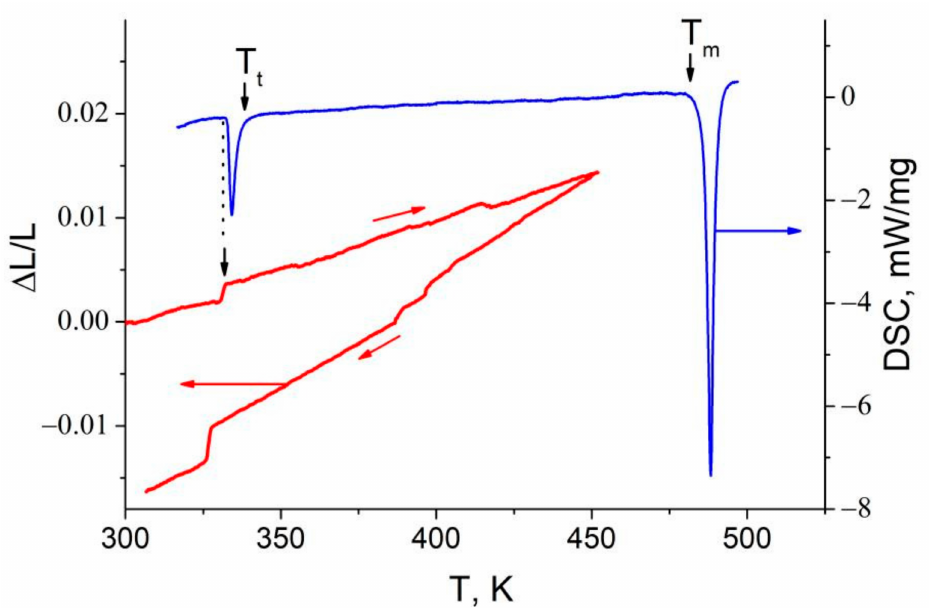
Figure 1. DTA curve obtained for TBAClO 4 powder on heating with a rate of 10 K/min and dilatometric data recorded on heating and cooling of TBAClO 4 pellet with the temperature change rate of 0.2 K/min. Temperatures of the polymorphous phase transition and melting are denoted as T t and T m ,